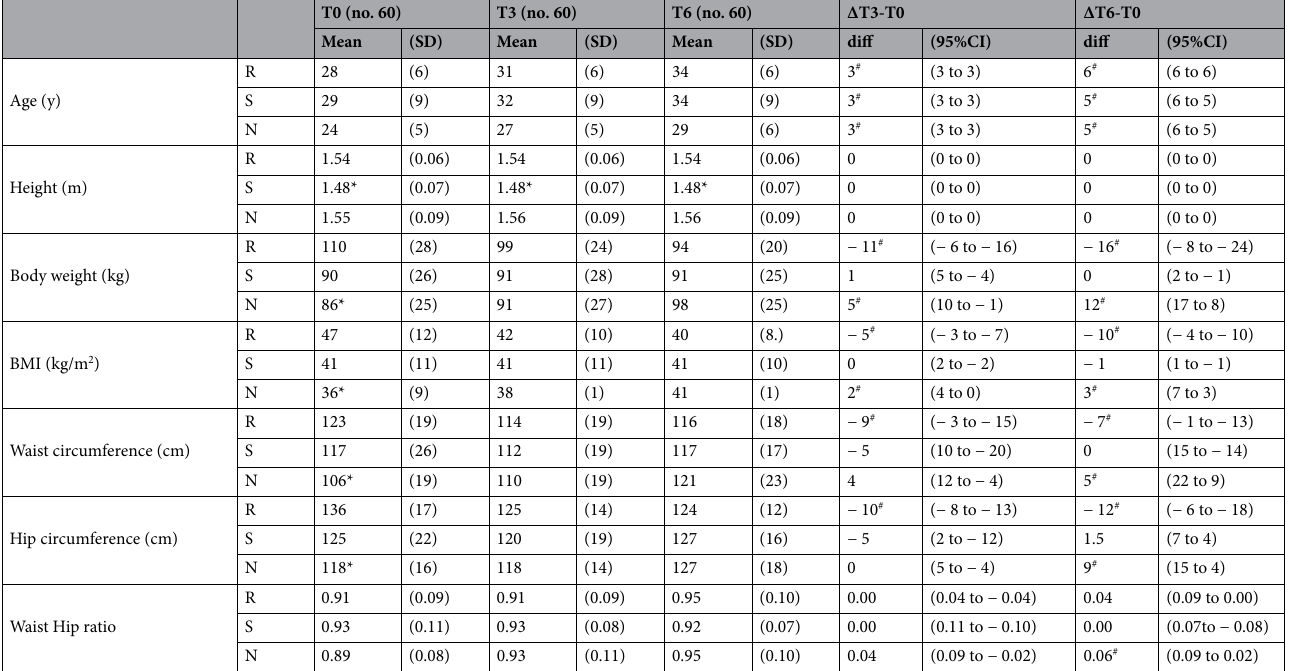
Table 1. Age and anthropometric measurements of Prader–Willi syndrome (PWS) patients at baseline, after 3 and 6 years follow-up. Measurements are reported as mean and standard deviation (SD), while changes are reported as mean difference and 95% confidence interval (CI). *: significantly different from the responsive subgroup ( p < 0.05); # : significantly changed compared to baseline. R: responsive patients; S: Stable patients; N: non-responsive patients; BMI: body mass